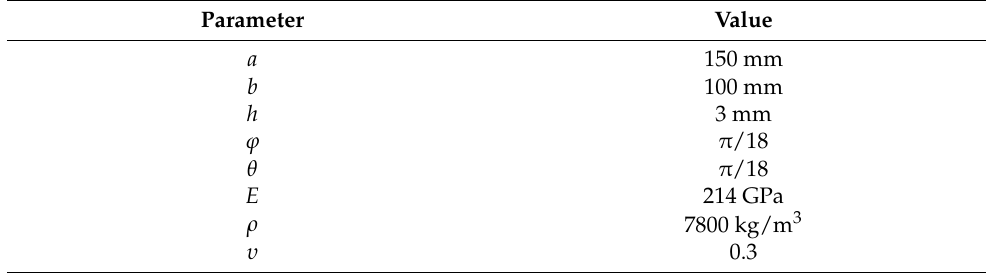
Table 3. Structural and material parameters.